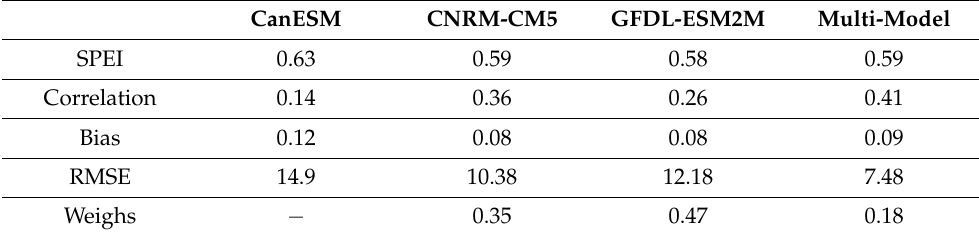
Table 6. Comparison of individual SPEI drought index and weighted SPEI during period of